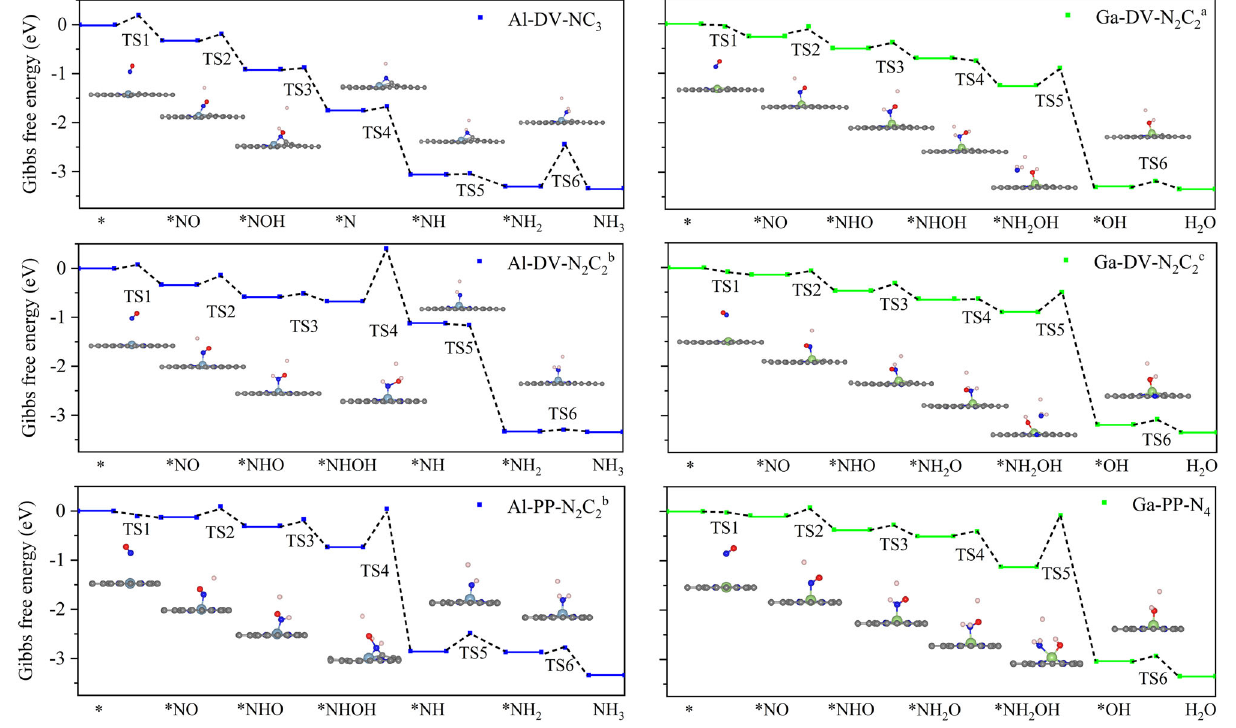
Fig. 5 Kinetic barriers. Corresponding kinetic barriers of the six screened SACs during the NORR toward NH 3 synthesis along the most thermodynamic favored reaction pathway. The insets are the structures of the transition